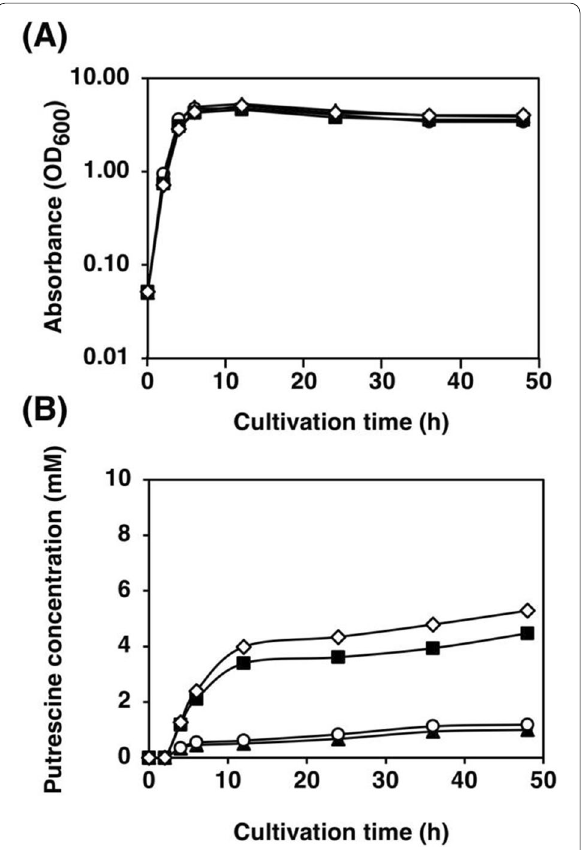
genome on putrescine production. A Bacterial cell growth and B putrescine concentration in the supernatant of strains KT39 (Δ argA , open circle) and KT207 ( argA + , closed triangle) grown in LB medium supplemented with 100 μg/mL of ampicillin. When the OD 600 reached 0.4, 0.02 mM IPTG was added. Data shown are averages standard deviations, and culture experiments were ± performed in triplicate